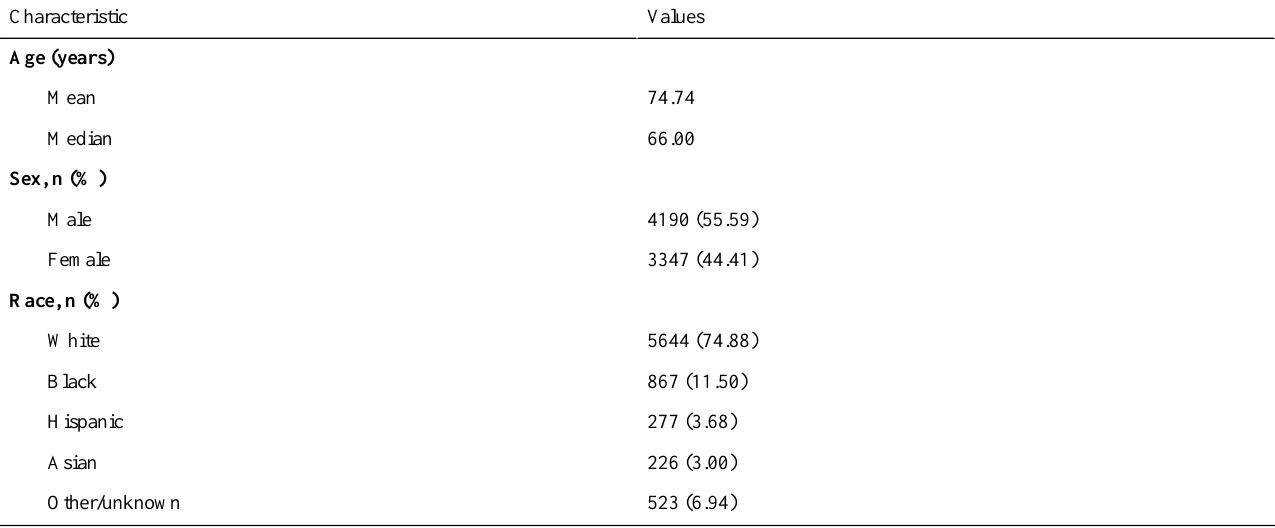
Table 1. Patient demographic information